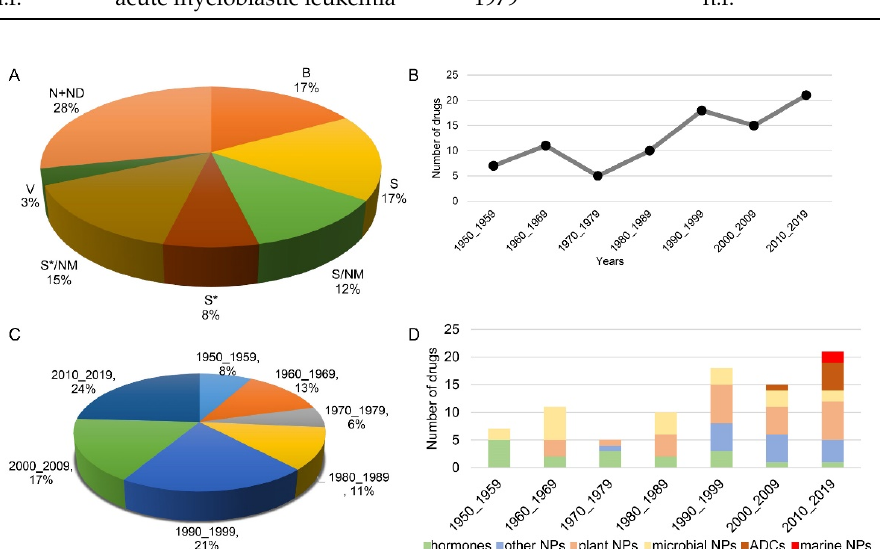
Figure 1. All approved anticancer drugs derived from natural products from 1950 to 2019. ( A ) The sources of anticancer drugs approved from 1950_2019 and their proportions. N: natural product. ND: natural product derivative. B: biological macromolecule. S: synthetic drug. NM: mimic of natural product. S*: synthetic drug with NP pharmacophore. V: vaccine. ( B , C ) Anticancer drugs derived from natural products. ( D ) All approved anticancer natural products by source/year. ADC: antibody drug conjugate. Table 1. All natural anticancer drugs approved from 1950 to 2021. Year Source Ref. Intro. plant NPs